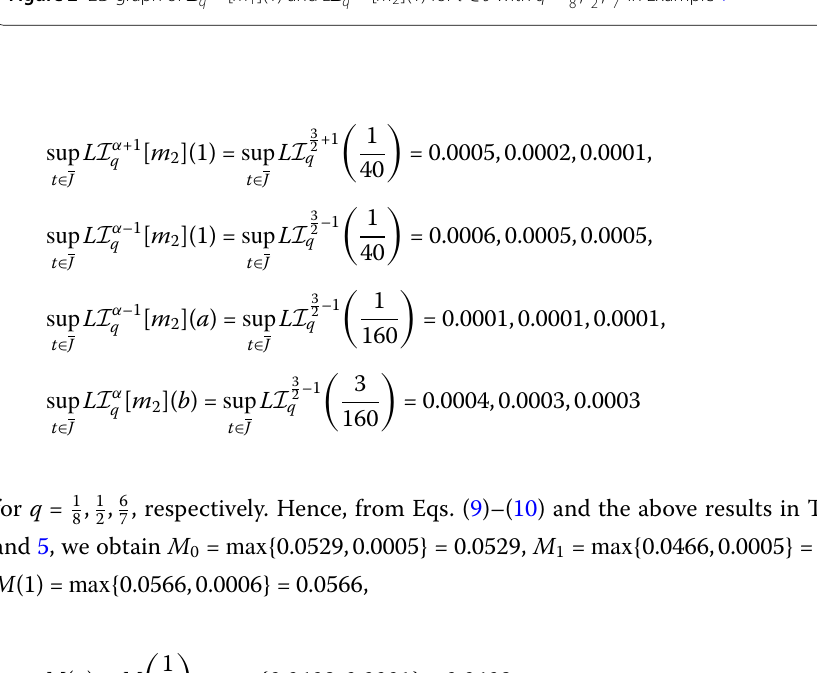
Figure 2 2D graph of I α +1 q [ m 1 ](1) and L I α +1 q [ m 2 ](1) for t ∈ J with q = 1